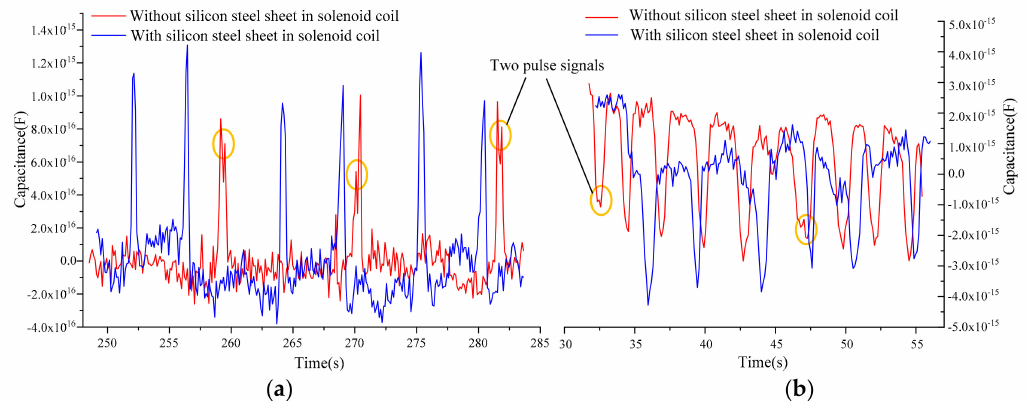
Figure 8. Capacitance detection results of 140 to 150 µ m water droplets and 240 to 250 µ m bubbles: ( a ) detection results of 140 to150 µ m water droplets; ( b ) detection results of 240 to 250 µ m bubbles. The red line is the detection results without silicon steel sheets, and the blue line is the detection results with silicon steel